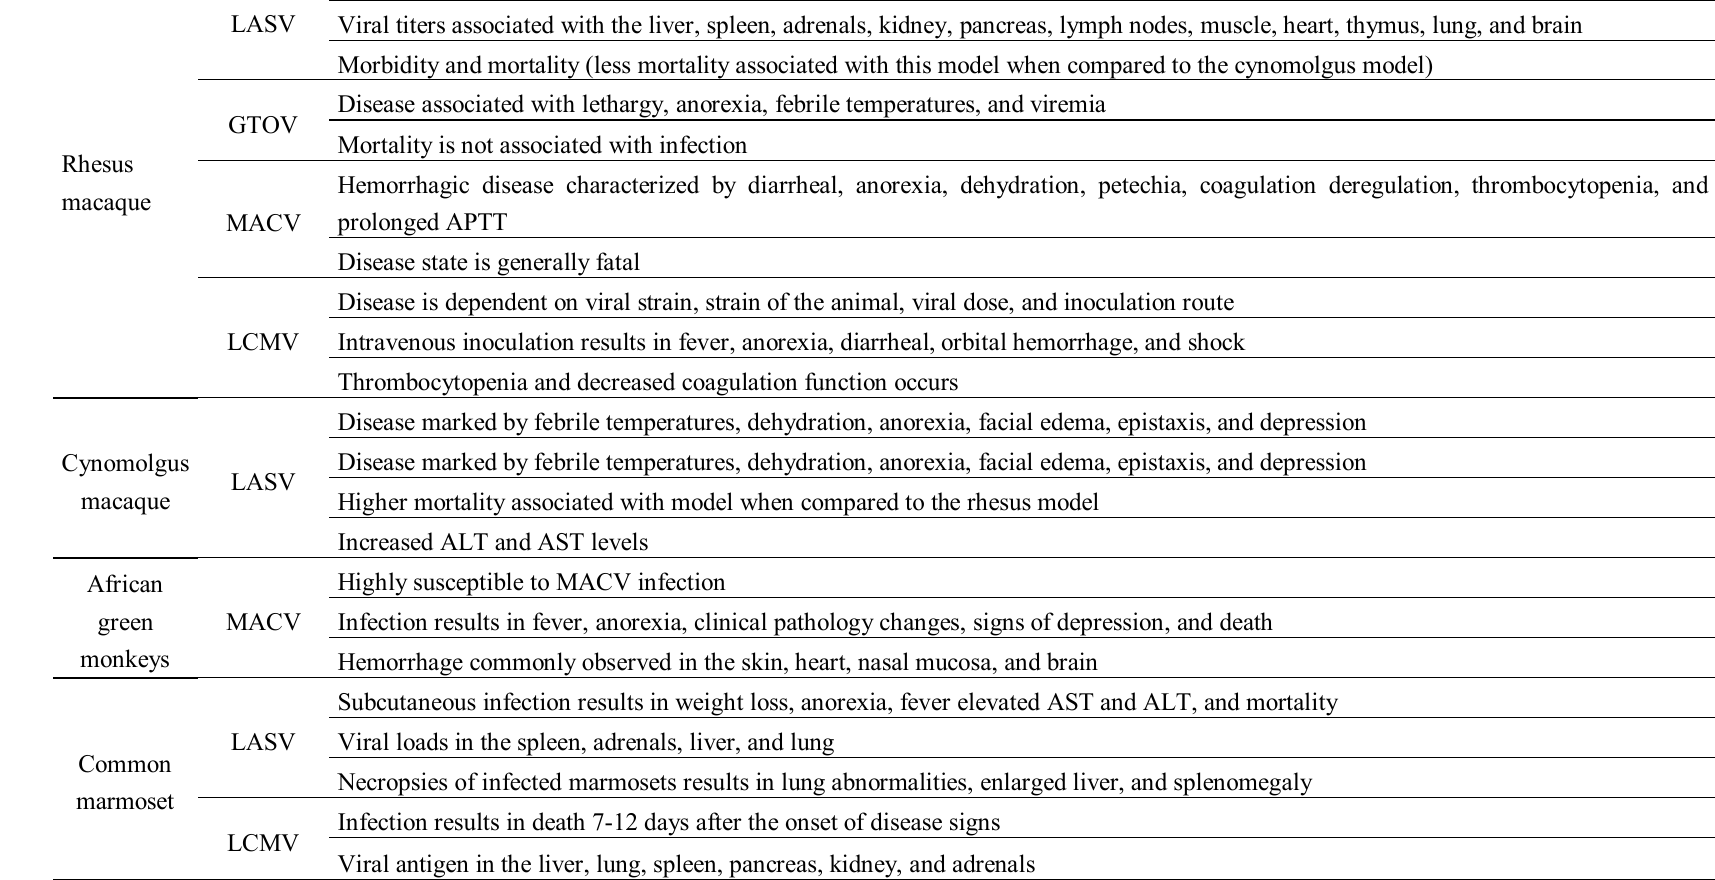
Table 3. Arenavirus–Nonhuman Primate